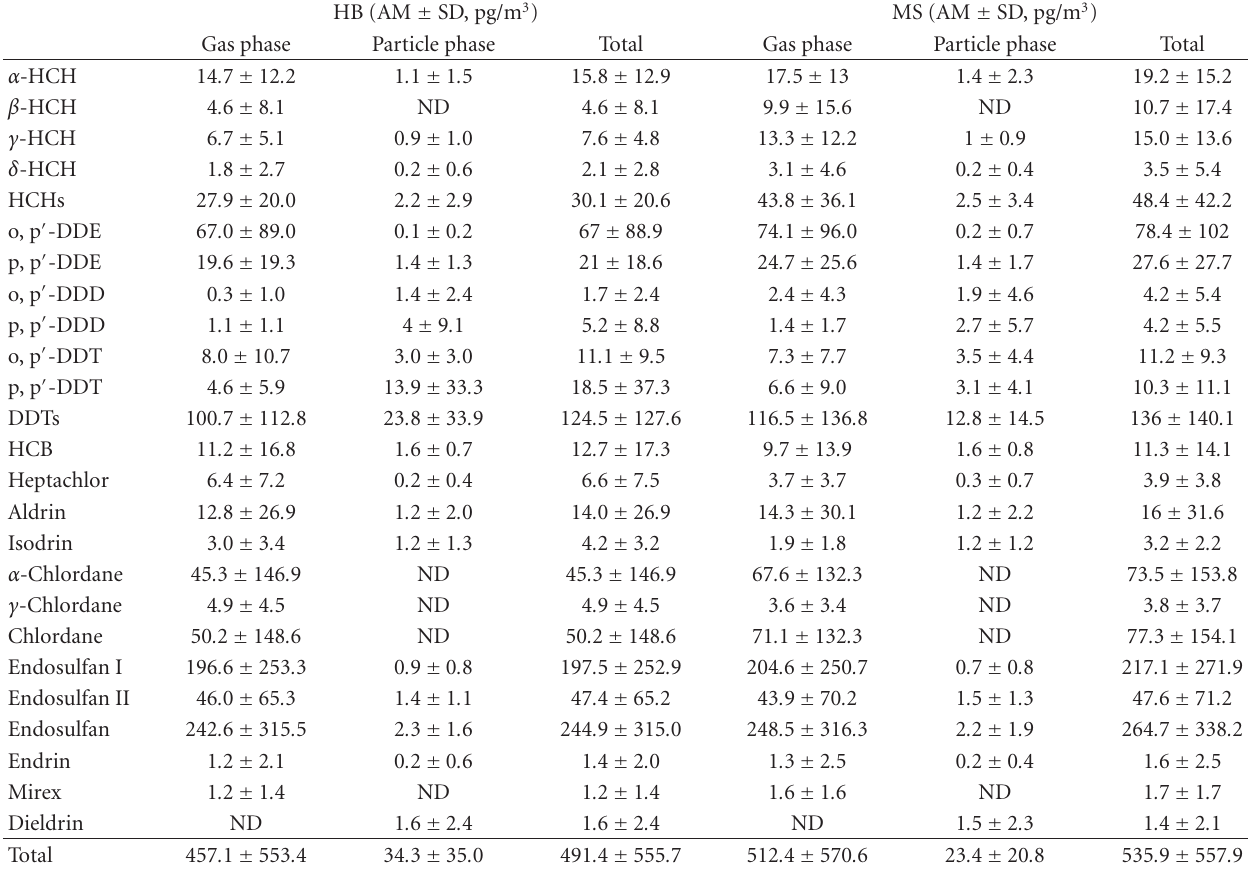
Table 3: Residual levels of OCPs in ambient air at the HB and MS from March 2010 to February